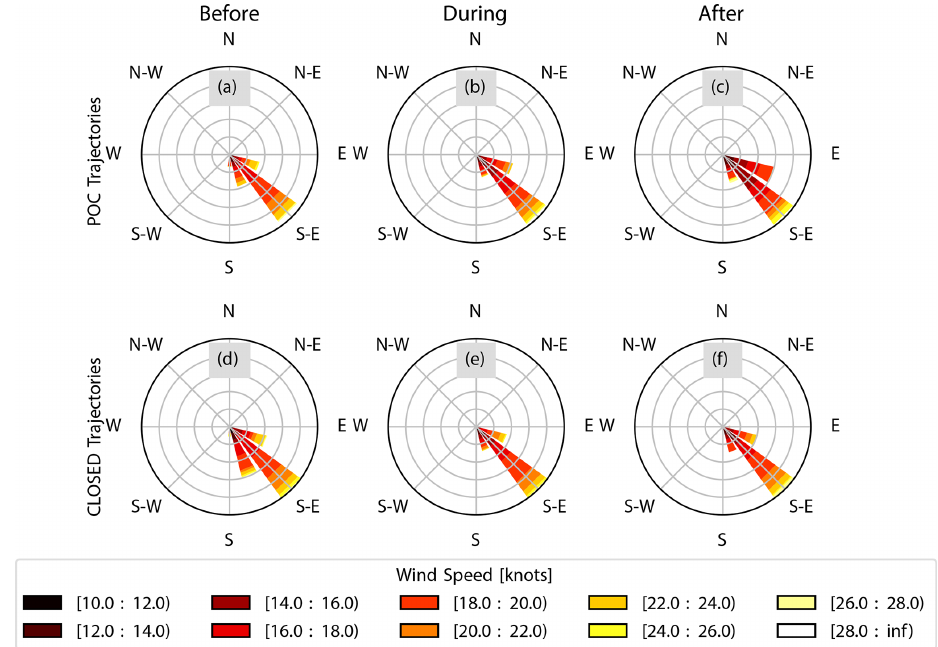
Figure 17. Wind rose plots are used to show the most common 925mb wind speed and direction before a POC (a, d) , during a POC (b, e) , and after a POC ends (c, f) . The wind rose plots in the top row represent the trajectories that intersect a POC, while those in the bottom row represent the trajectories that do not intersect a POC.